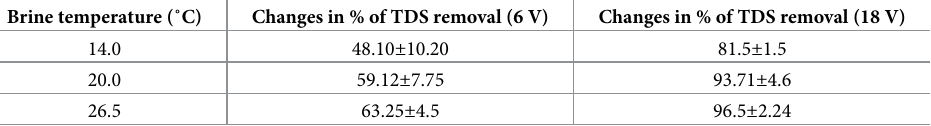
Table 4. The statistical analysis of the trend of TDS removal from the brine at different temperatures and voltages (the second and the third